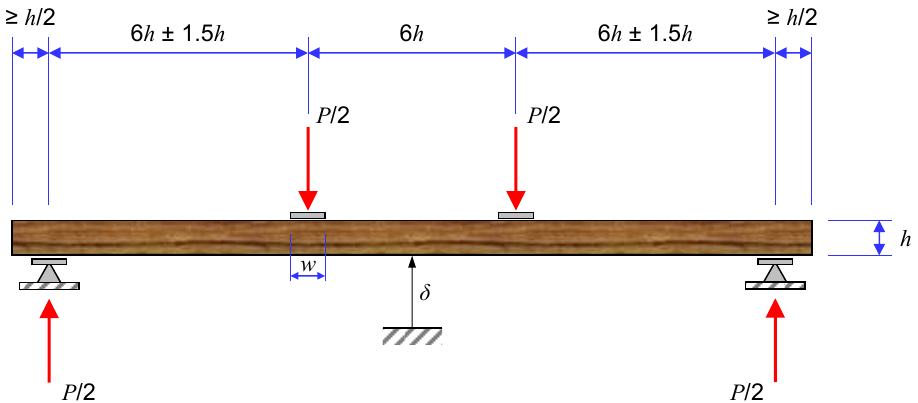
Figure 4. A scheme of the four-point bending test configuration for determining the shear properties of wood.